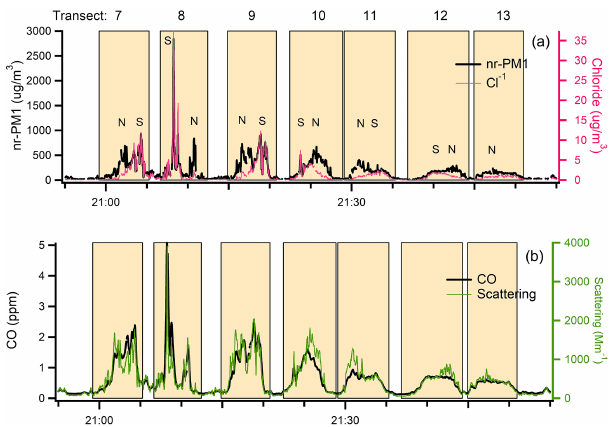
Figure 5. Time series data from flight 730b for (a) nr-PM1 and Cl − (b) CO and light scattering. Data contributing to transect averages are identified by shaded rectangles. Transect numbers and North, South designation correspond to those in Fig. 3. Transects are lim- ited to 1–6 from Set 1 for visibility. The increase in the ratio of scattering to CO is particularly pronounced in the low Cl parts of downwind transects.